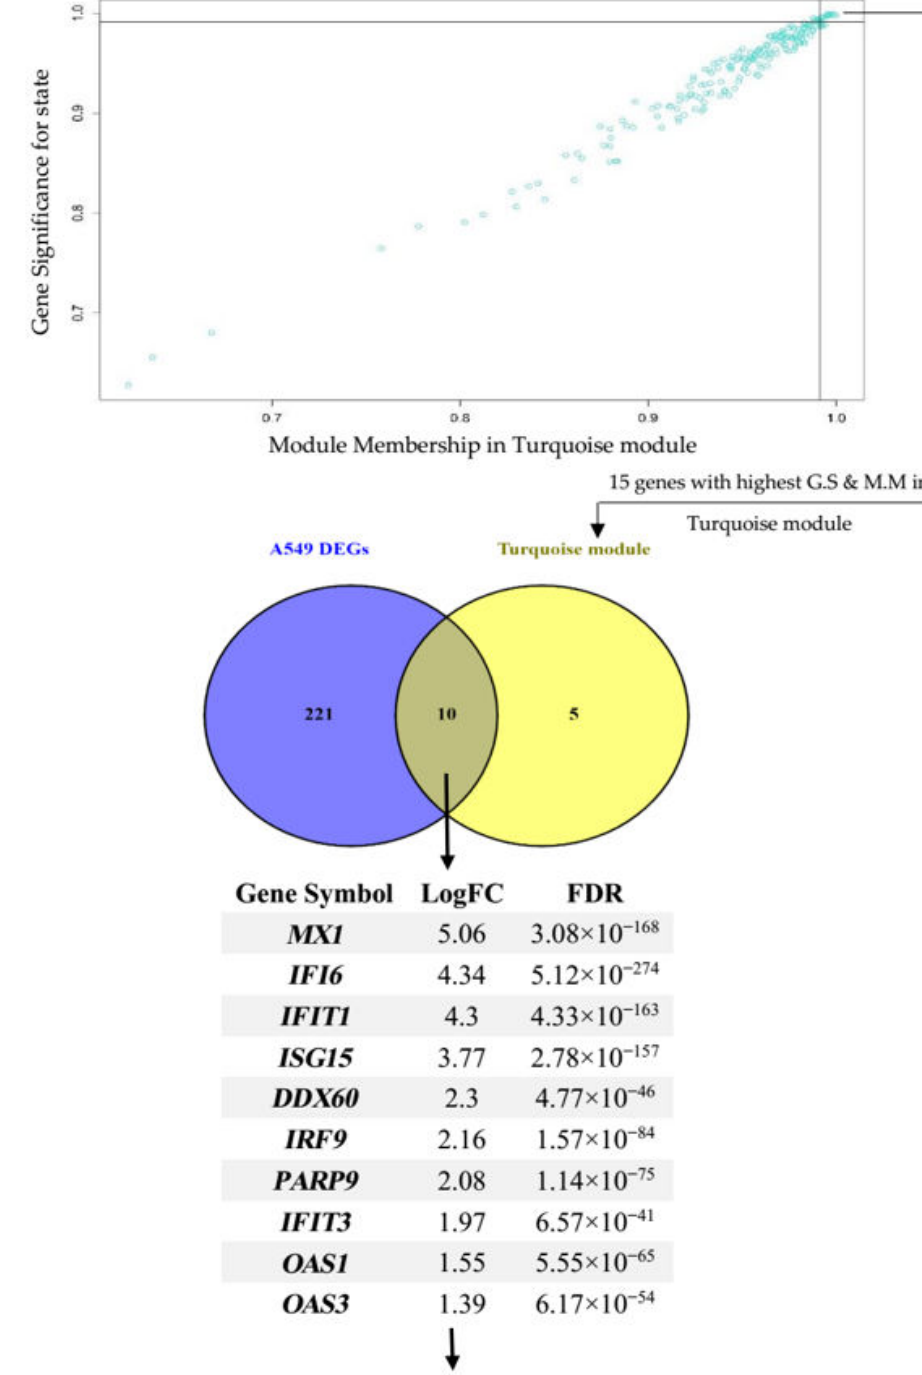
Figure 4. Hub gene detection for the A549 dataset. ( A ) Turquoise module features of G.S and M.M significantly correlated with the SARS-CoV-2 trait (mock-infected and SARS-CoV-2-infected). Each point represents an individual gene within each module, which is plotted by G.S on the y-axis and M.M on the x-axis; ( B ) Evaluation of similarities between DEG and hub gene lists using a Venn diagram. Ten genes that were similar in both lists were then imported to GeneMANIA to construct a co-expression